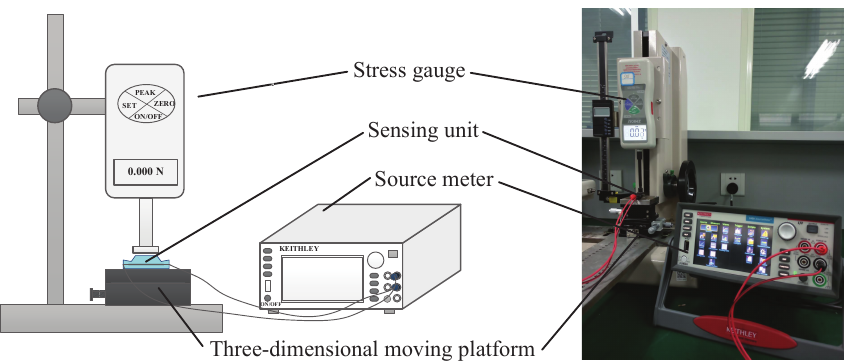
Figure 7. Schematic view and photograph of the